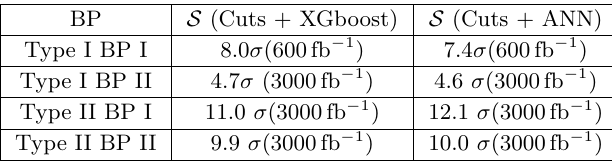
Table 10 . Signal signi(cid:12)cance for the benchmark points at 14 TeV in the vector fusion channel with XGboost and ANN techniques after applying some initial